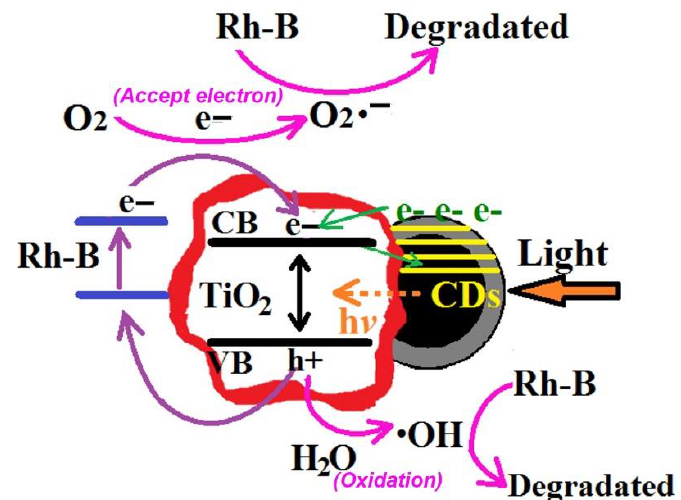
Figure 8. Schematic description of the proposed photocatalysis mechanism.